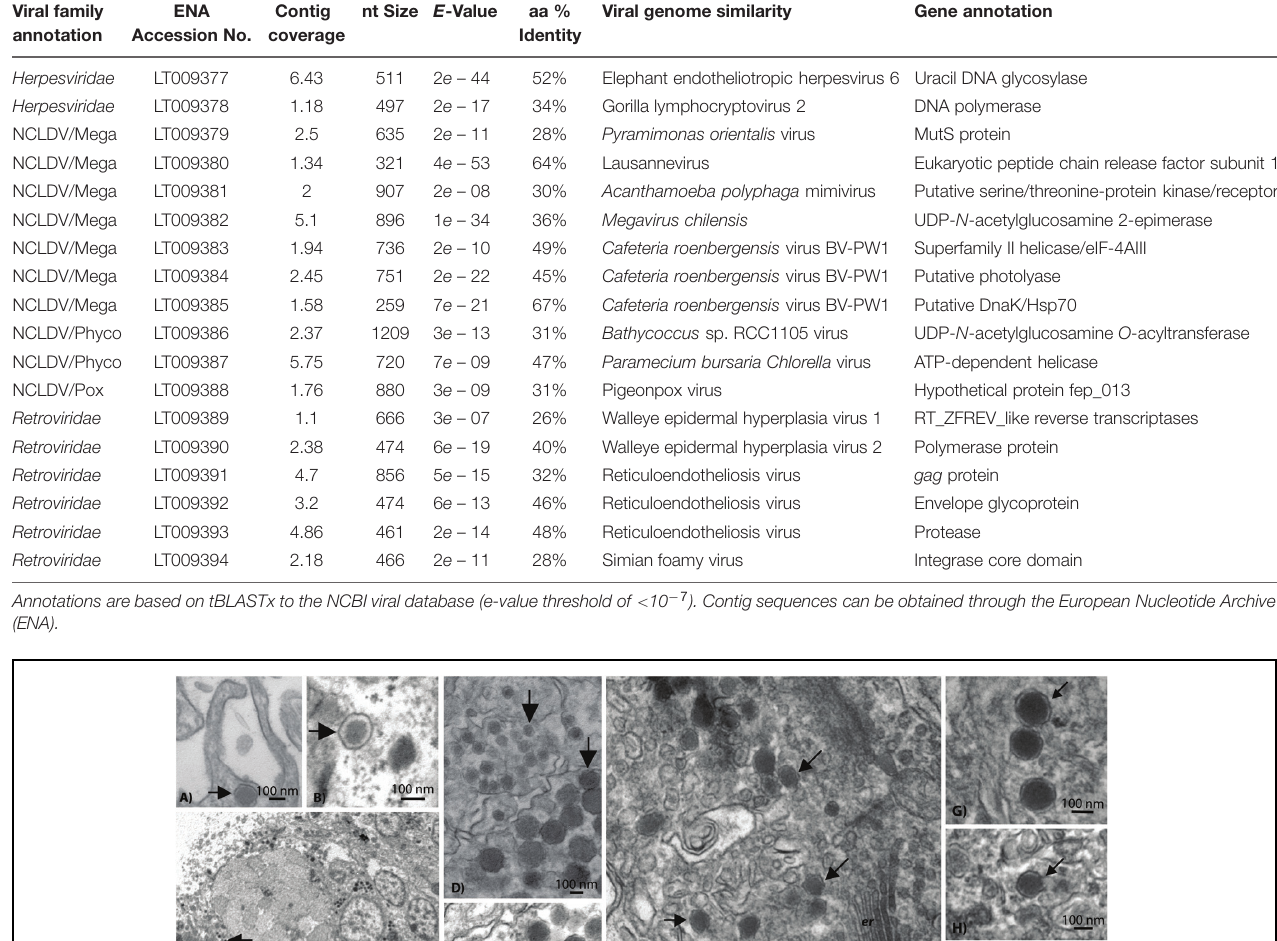
TABLE 1 | Examples of gene annotations from a single control Acropora aspera virome (generated from five coral fragments), including those from Herpesviridae , the Nucleocytoplasmic Large DNA Viruses (NCLDVs), and Retroviridae . Viral family annotation